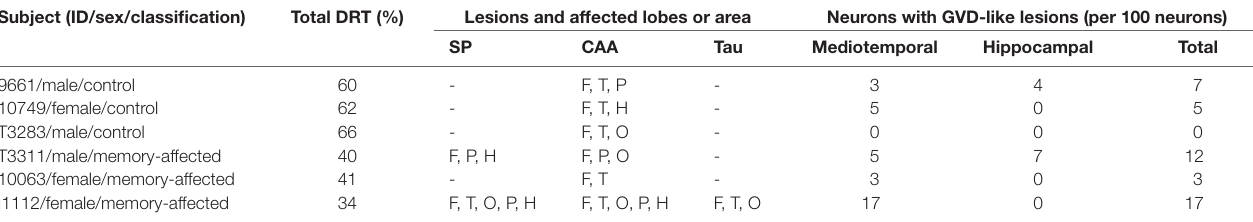
TABLE 1 | Quantitative analysis of the lesions with subject